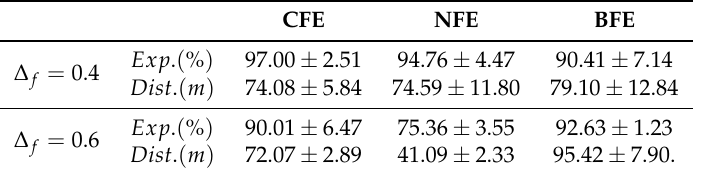
Table 4. Comparison of exploration in map 1 with different frontier threshold values.